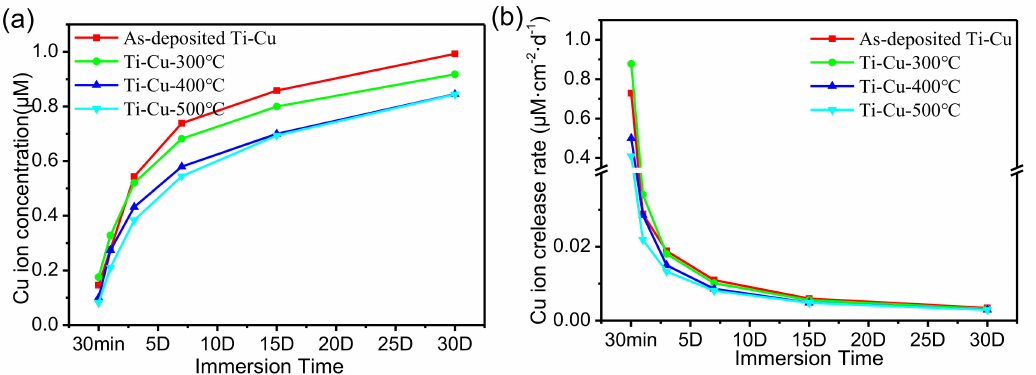
Figure 10. ( a ) The accumulated Cu ions and ( b ) release rate of Cu ions of the deposited and annealed Ti–Cu coatings (300 ◦ C, 400 ◦ C, 500 ◦ C) deposited on silicon substrates after immersion in PBS solution (pH = 7.4) for durations from 30 min to 30